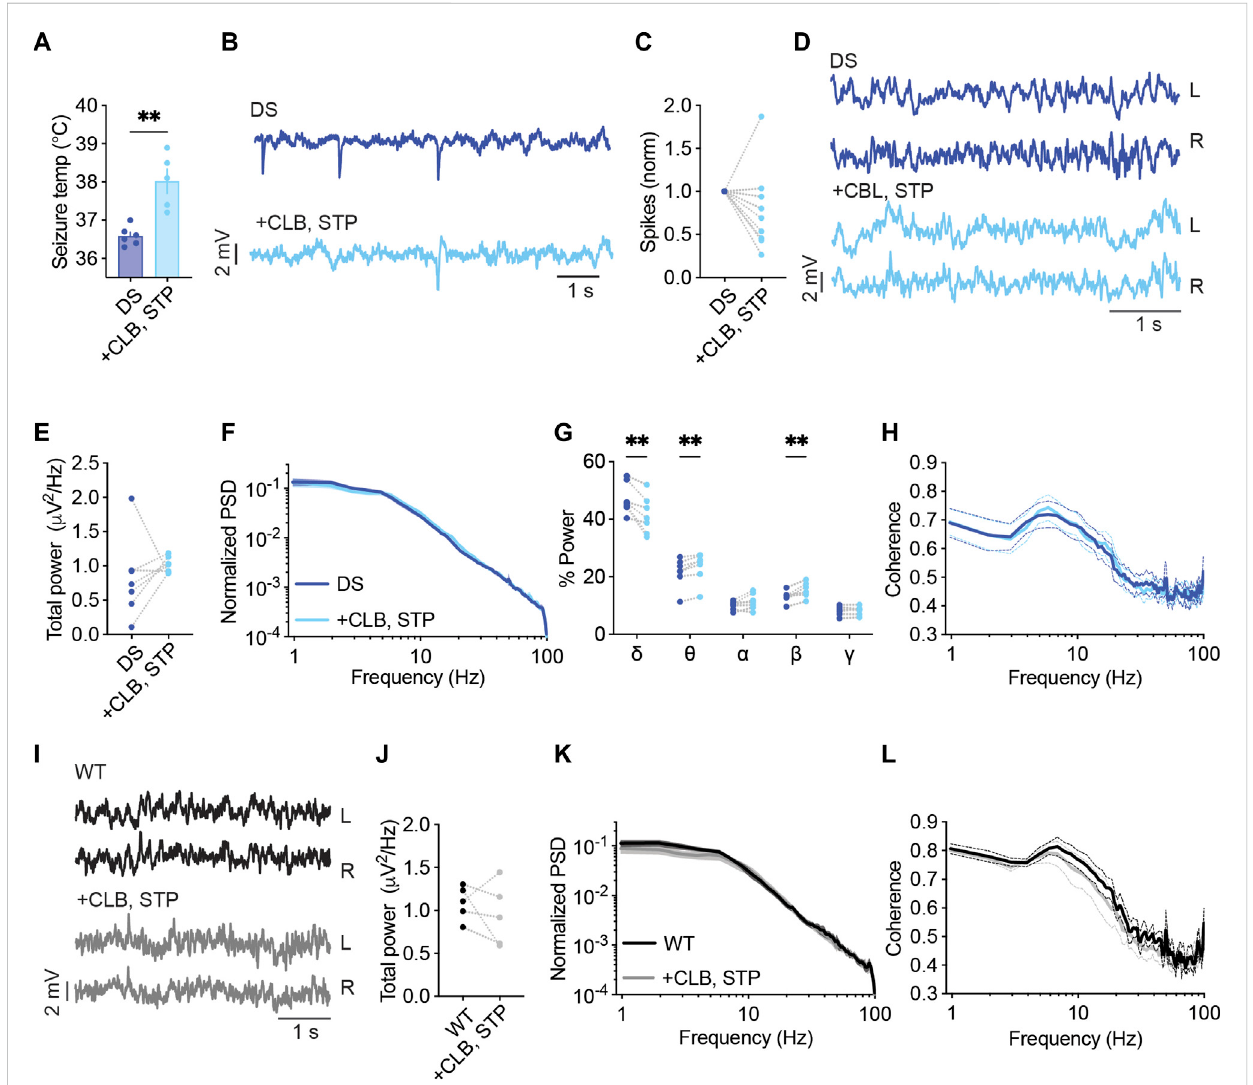
FIGURE 4 CLB + STP treatment modulates the spectral properties of background ECoG in DS mice. (A) CLB + STP (5,100 mg/kg, respectively) protected against hyperthermia-induced seizures in DS mice. DS mice injected with sesame oil as vehicle, n = 6; DS mice injected with CLB + STP, n = 5. (B) Representative traces of epileptic activity before and after acute administration of CLB + STP. (C) The change in the frequency of interictal spikes. (D) Representativeexamplesofbackgroundactivity. (E) Theeffectontotalpower. (F) ECoGpowerdensitypro fi lesnormalizedtothetotalpowerpriorto drug administration. (G) The relative power in each frequency band. (H) Interhemispheric coherence plotted over the 1 – 100 Hz spectrum. DS, n = 7. (I) Representative traces of background ECoG from WT mice before and after drug administration. (J) The effect of CLB + STP on total power. (K) ECoG power density pro fi les normalized to the power prior to drug administration. (L) Interhemispheric coherence plotted over the 1 – 100 Hz spectrum. WT, n = 5. ** p <